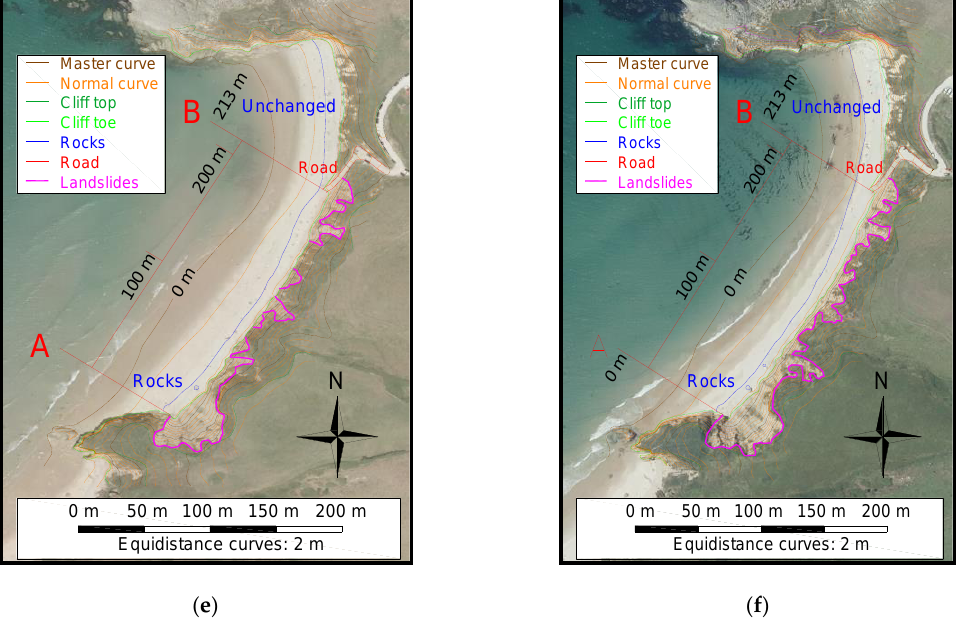
Figure 5. ( a ) Delimitation of the coastline in the orthophoto of the American flight (1956). DEMs (height contours every 2 m) for the years ( b ) 2001; ( c ) 2005; ( d ) 2010; ( e ) 2014; ( f ) 2017.